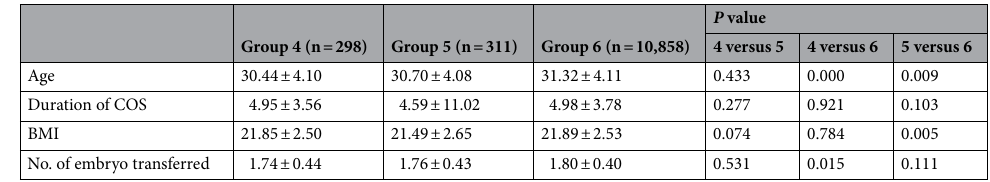
Table 2. Characteristic of women undergoing FET